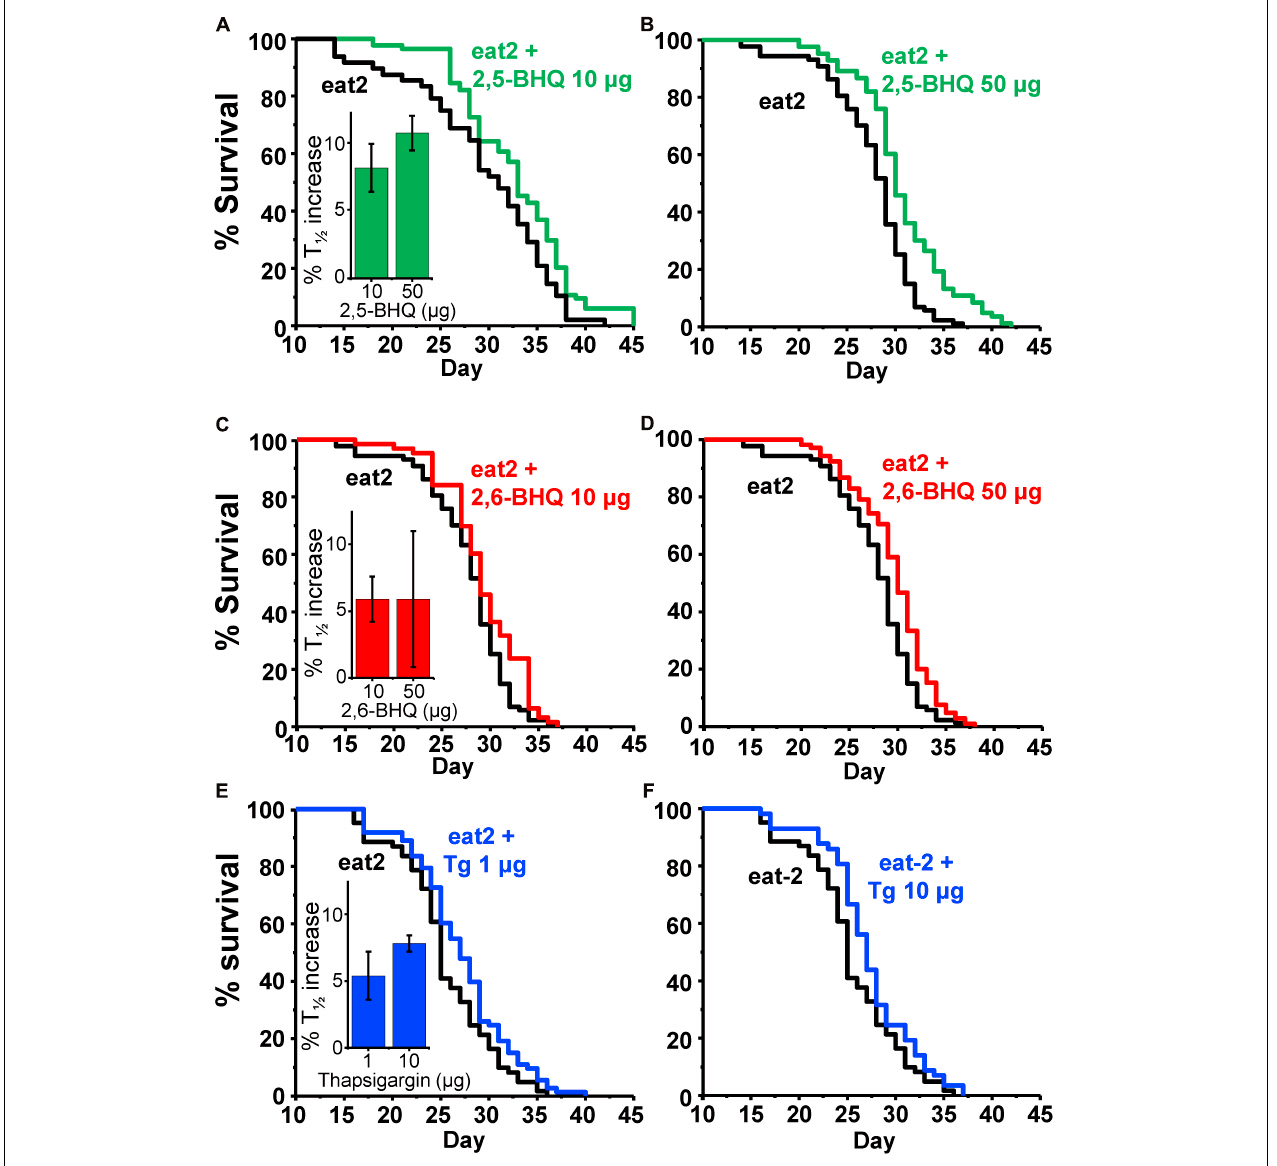
FIGURE 3 | Effect of SERCA inhibitors on survival in eat-2 C. elegans mutants. The panels show representative survival plots corresponding to parallel lifespan assays performed using γ -cyclodextrin-inclusion compounds in the following conditions: eat-2/ eat-2 + 2,5-BHQ ( A :10 µ g; B :50 µ g), eat-2/ eat-2 + 2,6-BHQ ( C :10 µ g; D :50 µ g) and eat-2/ eat-2 + thapsigargin ( E :1 µ g, F :10 µ g). The assays correspond to those marked in bold in Table 3 . The inserts show the mean increase in survival obtained in a series of lifespan assays of each kind as those shown in the figure (more details of each assay in Table 3